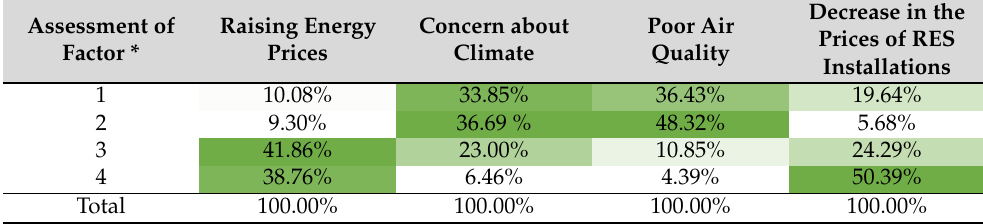
Table 3. Structure of assessments of factors encouraging users to invest in buildings using solely renewable energy sources.